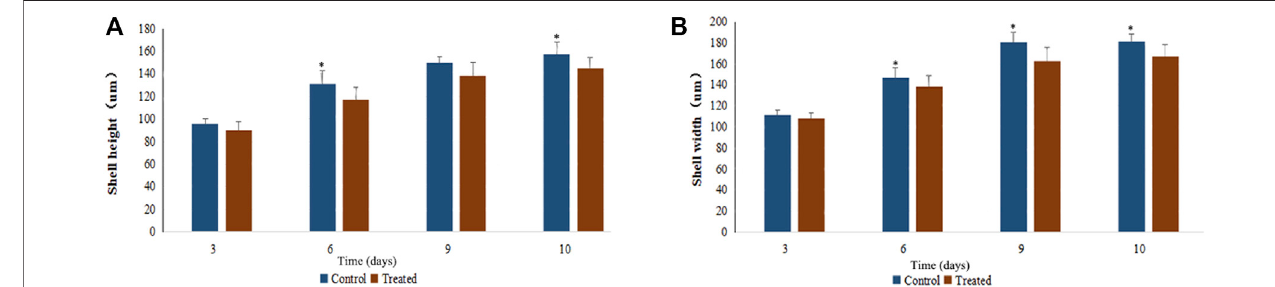
FIGURE 3 | Effects of EMS on growth in shell height (A) and shell width (B) of scallop larvae.